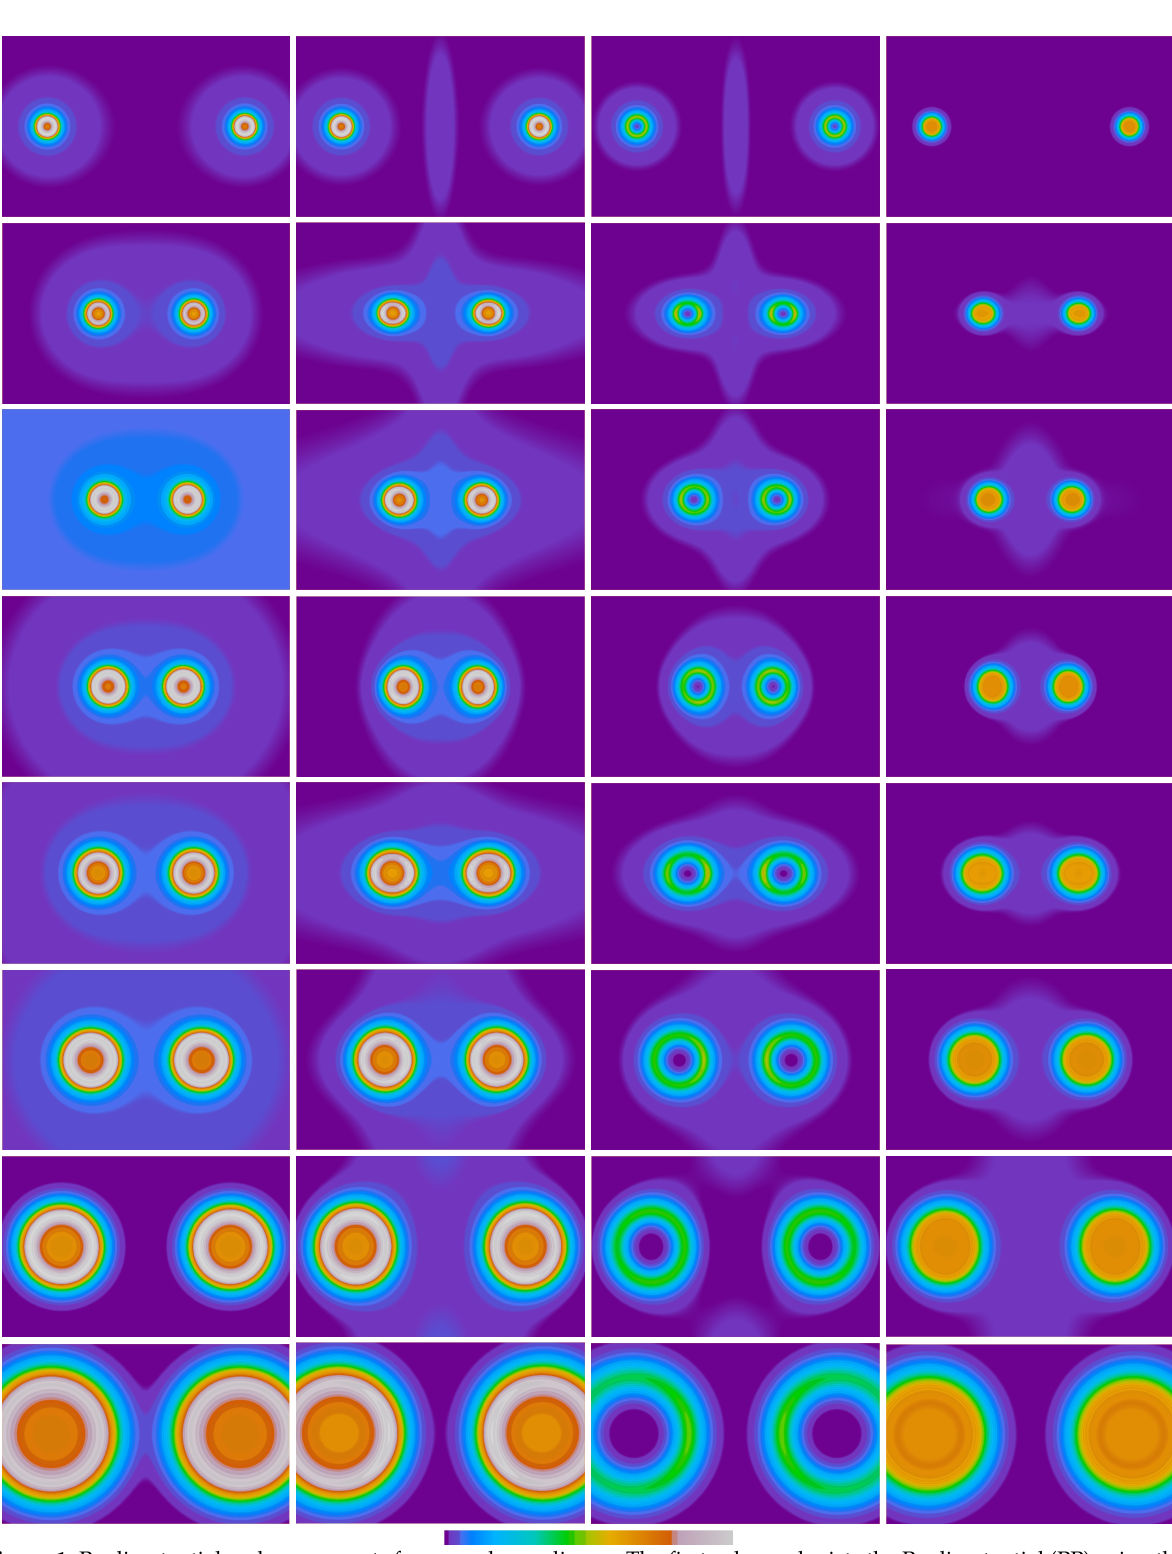
Figure 1. Pauli potential and components for second-row dimers. The first column depicts the Pauli potential (PP) using the bare atomic fragment approach. In the second column, the molecular PP evaluated from Kohn–Sham orbitals is compiled, together with its components t P ( (cid:126) r ) / ρ ( (cid:126) r ) and ∑ i ( (cid:101) M − (cid:101) i ) | φ i ( (cid:126) r ) | 2 / ρ ( (cid:126) r ) , cf. Equation (8), shown in columns three and four, respectively. First row: Ne 2 color scale from 0.0 (blue) to 41.0 (white). Second row: F 2 color scale from 0.0 (blue) to 36.0 (white). Third row: O 2 color scale from 0.0 (blue) to 26.0 (white). Fourth row: N 2 color scale from 0.0 (blue) to 18.5 (white). Fifth row: C 2 color scale from 0.0 (blue) to 14.3 (white). Sixth row: B 2 color scale from 0.0 (blue) to 8.9 (white). Seventh